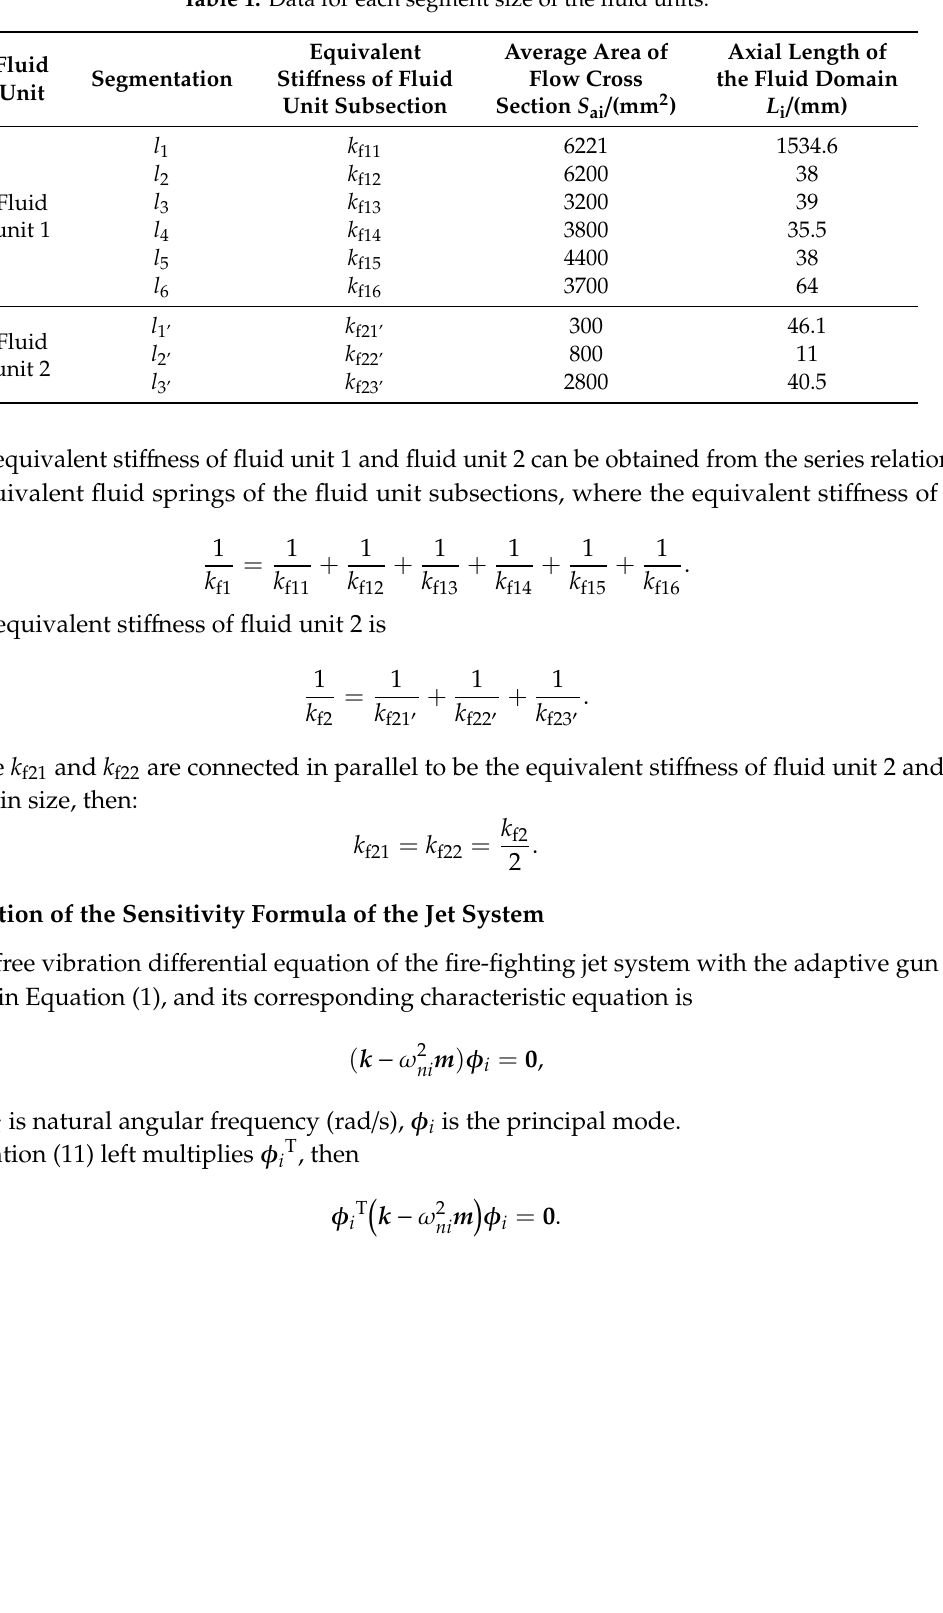
Table 1. Data for each segment size of the fluid